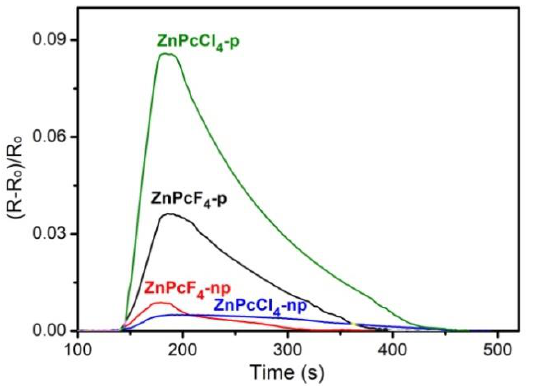
Figure 8. Response-recovery time of the ZnPcHal 4 sensing layers at 1 ppm ammonia, measured at room temperature and RH 10%. Table 2. Calculated detection limits and response/recovery times (at 1ppm NH 3 ) of ZnPcF 4 -np,